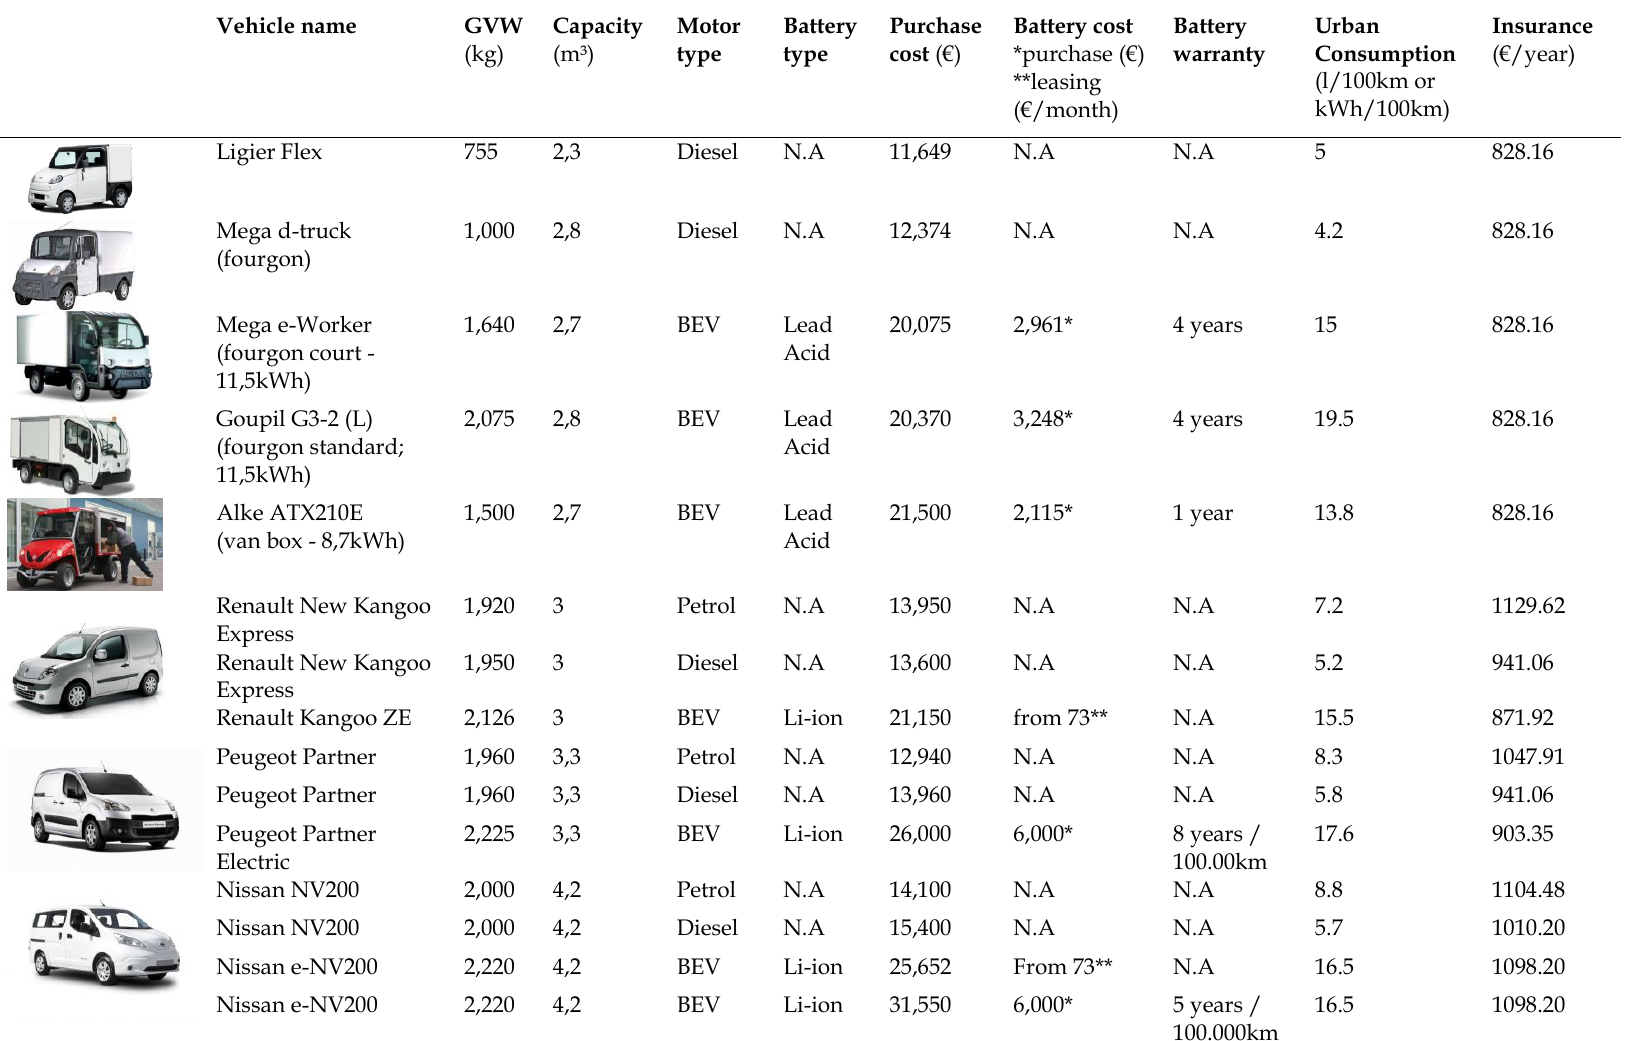
Table 1. Input parameters of the